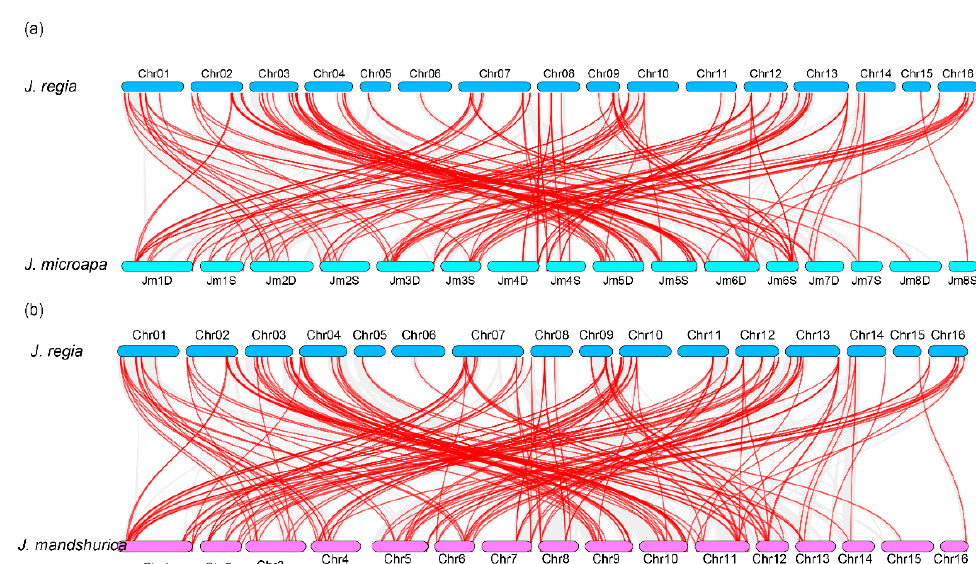
Figure 5. Syntenic analysis of WRKY genes in Juglans species, including J. microcarpa and J. mandshurica . ( a ) the syntenic analysis of WRKY genes between J. regia and J. microcarpa . ( b ) the syntenic analysis of WRKY genes between J. regia and J. mandshurica .